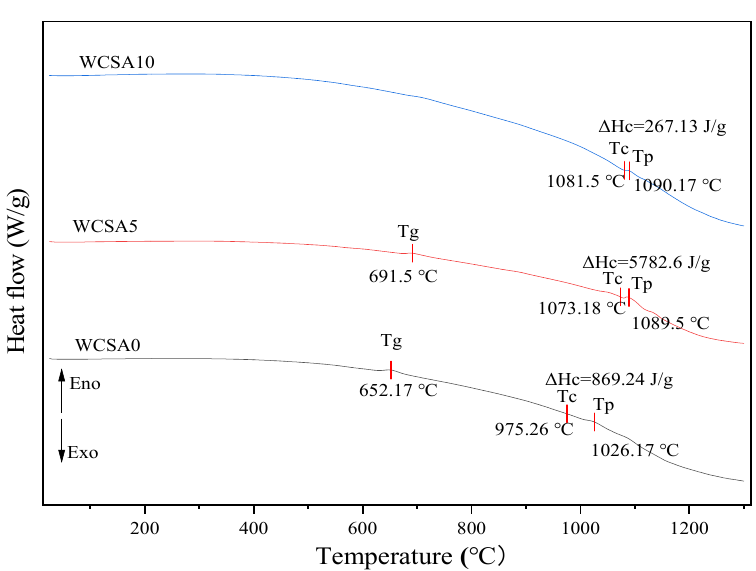
Figure 2. XRD patterns for the three groups of WCS.